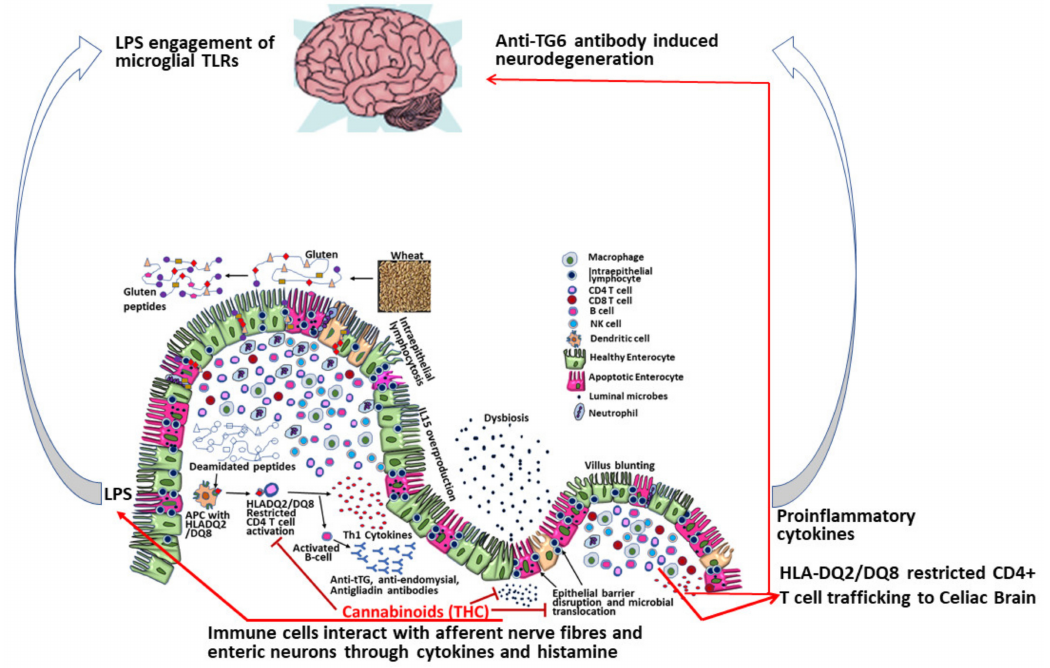
Figure 2. Immunopathology of central nervous system (CNS) disease in celiac disease patients and potential beneficial (treatment) role of phytocannabinoids as nutraceuticals to mitigate gluten induced intestinal and CNS inflammation. THC—delta-9-tetrahydrocannabinol; LPS—lipopolysaccharide; TG6—transglutaminase-6; TLR—Toll-like receptor; APC—antigen presenting